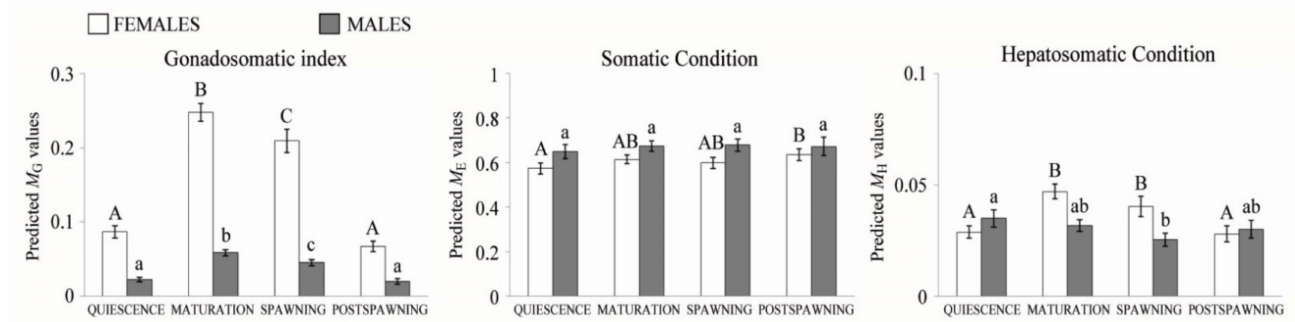
Figure 3. Mean predicted M G, M E and M H values by ANCOVA ( L F as covariate) in each reproductive stage (quiescence, maturation, spawning and postspawning) for both sexes of Gobio lozanoi . Letters show significant differences (Welch’s analysis of variance p < 0.05 and T3 of Dunnett post hoc tests) among reproductive stages in females (capital letters) and in males (lowercase letters). Table 2. Mean predicted M E, M H and M G values by ANCOVA ( L F as covariate) in each reproductive stage for both sexes of Gobio lozanoi . ANOVA results of comparison of somatic condition (SC), hepatosomatic condition (HC) and gonad activity (GSI) among reproductive stages in each sampling site are showed and significant p -values are included. Codes of sampling sites (TUS, SE1, SE2, SE3, and SE4) from the Segura River Basin were included. Reproductive Stages Sampling Site